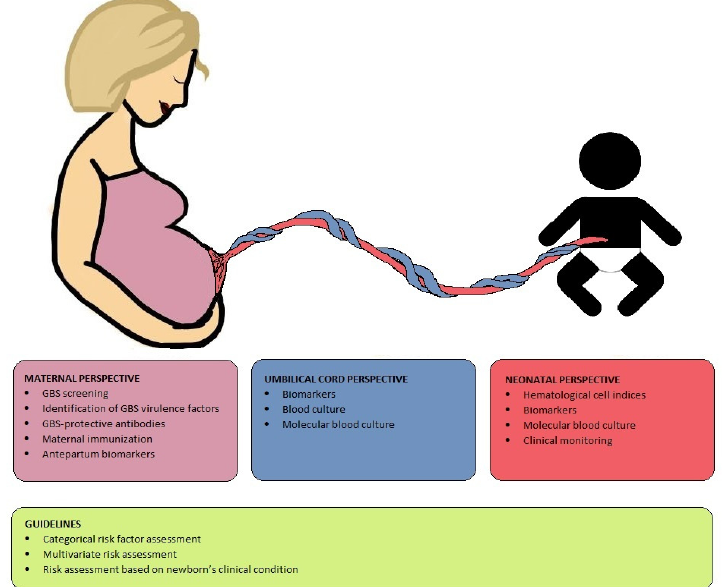
Figure 1. Overview of diagnostic and preventive strategies for EONS from three different perspec- tives, complemented with the various assessment methods ofthe guidelines. complemented with the various assessment methods ofthe